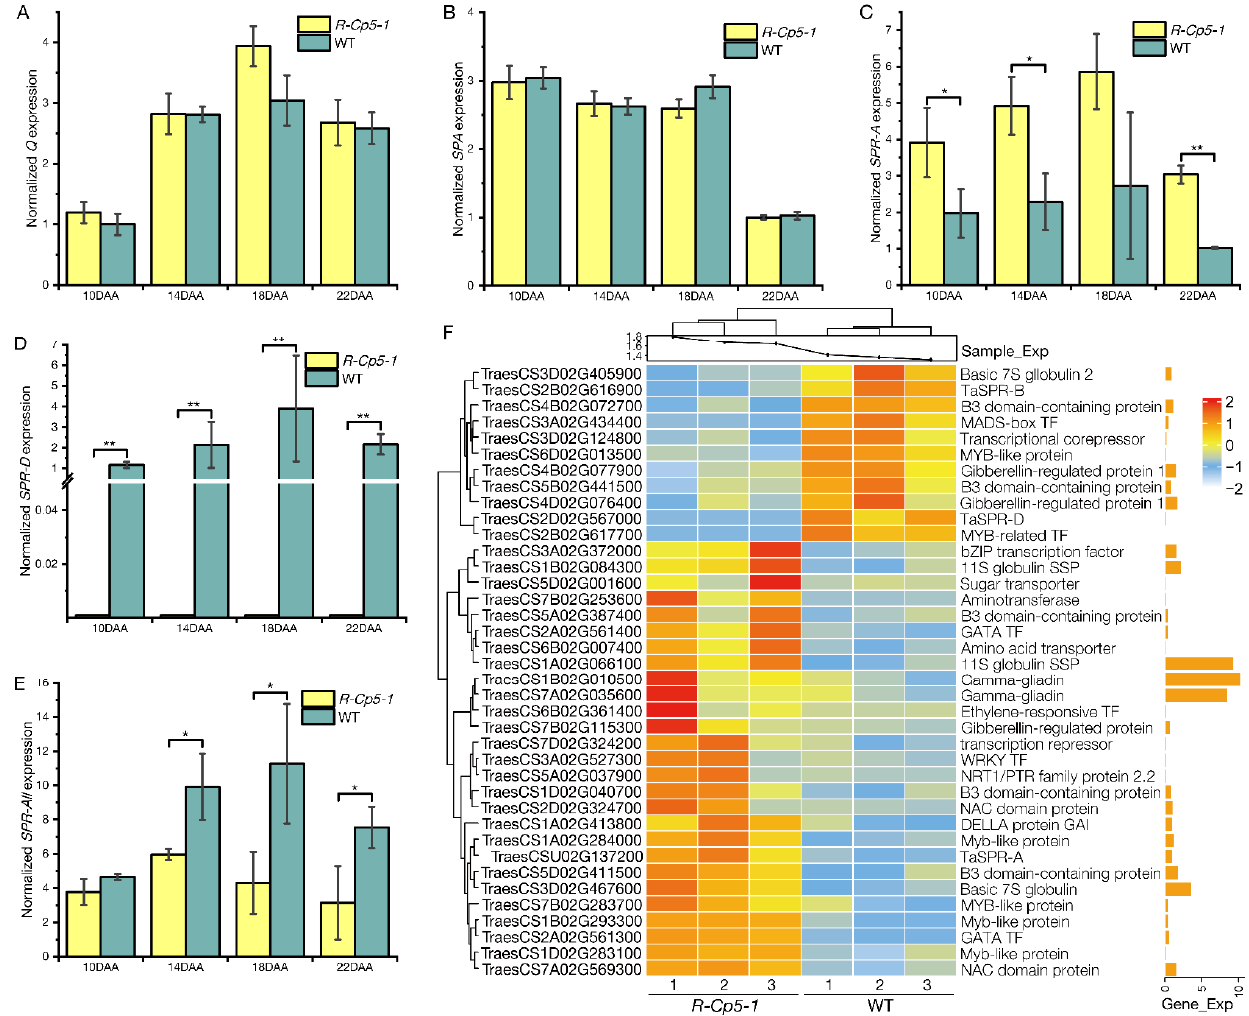
Figure 5. Relative expression of Q ( A ), SPA ( B ), SPR-A ( C ), SPR-D ( D ), and SPR-All ( E ) in developing seeds. Data are presented as the mean ± standard deviation ( n = 3; *, p ≤ 0.05; **, p ≤ 0.01). ( F ) Heat map presenting the mean normalized expression of selected DEGs. The scale bar indicates the mean normalized expression level. Sample_Exp is the mean expression of all genes in every sample; Gene_Exp is the mean expression of each gene. The histograms reflect the relative expression levels. All DEGs are listed in Tables S5 and S6.